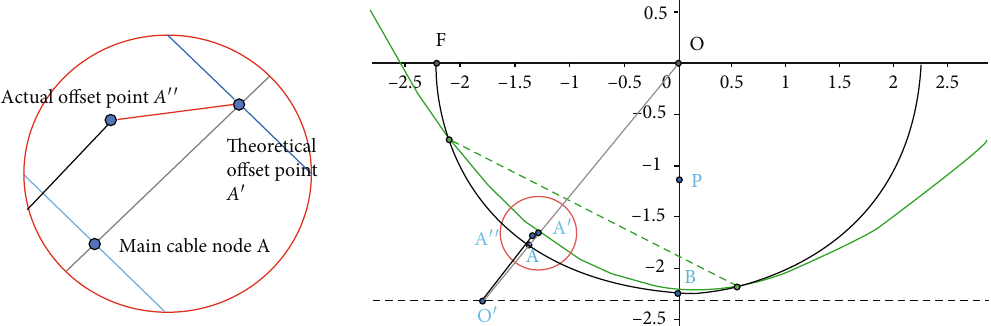
Figure 3: Displacement of main cable